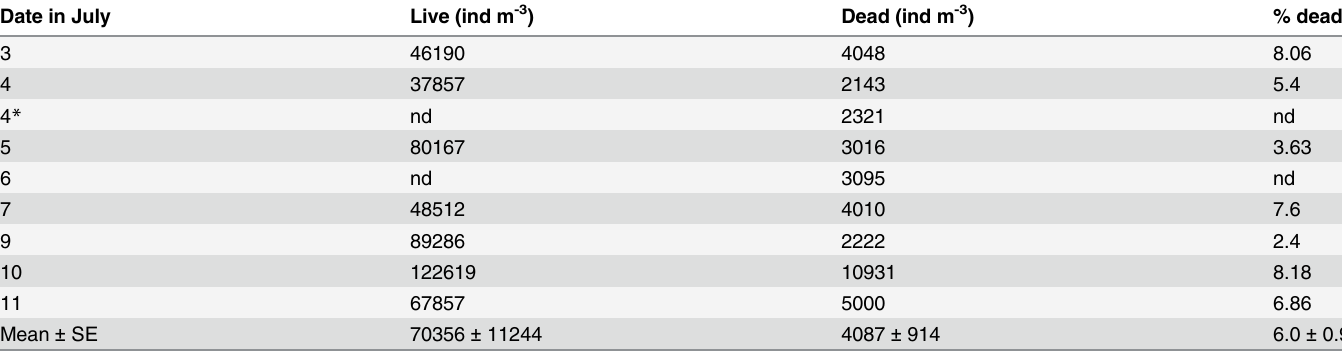
Table 2. Abundance and % dead of Bosmina longirostris at trap depth (12 m) in Lake Stechlin. Date in July